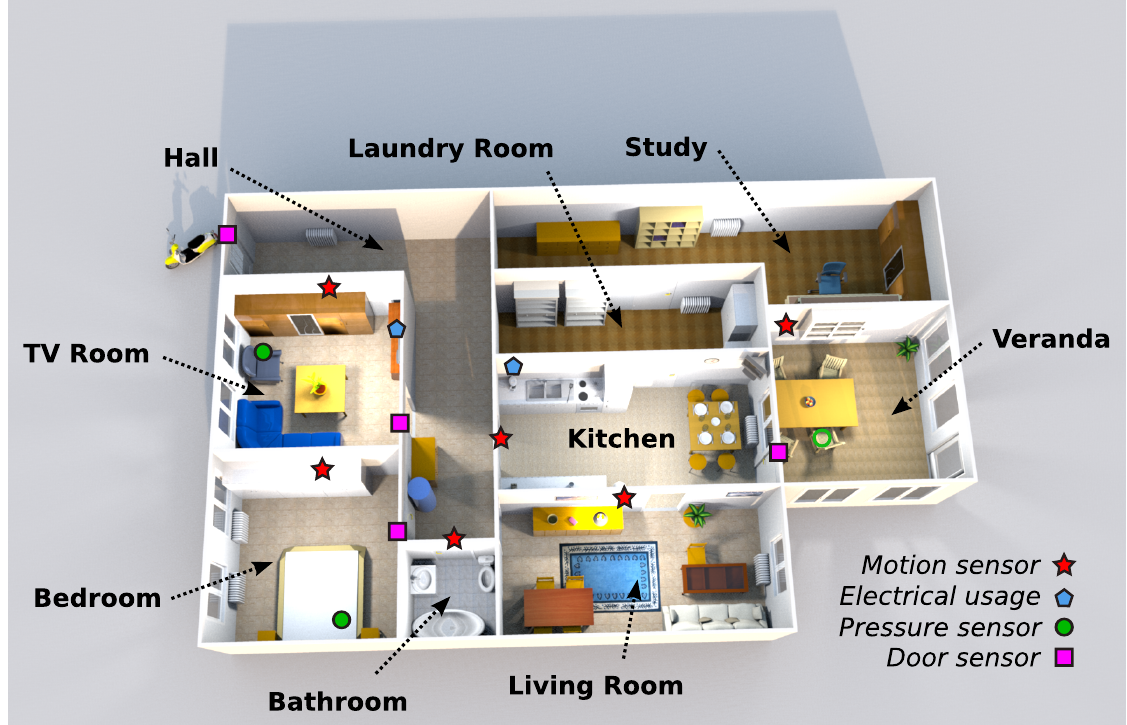
Figure 9. The map of one of the test site in Sweden showing the sensor